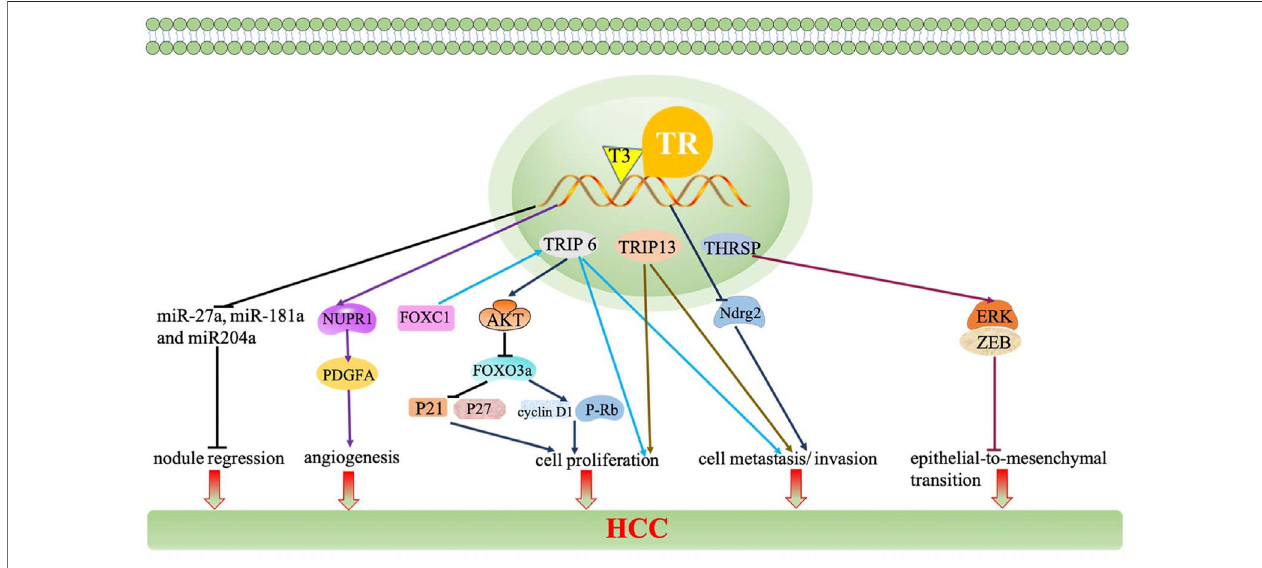
FIGURE 3 | The TH/TR axis inhibits nodule regression and decreases the expressions of miR-27a, miR-181a, and miR-204a. BC200 is inhibited by T3/TR and downregulates the expressions of CDK2, cyclin E1, and cyclin E2 and upregulates P21, thereby repressing cell growth. The downregulation of TUG1 by the TH/TR axis causes AFP mRNA, cyclin E, and H3K27me3 silence and cell growth inhibition. When TRIP is activated by FOXC1, migration, invasion, and proliferation are strongly promoted. TRIP6 induces the AKT signaling pathway, thereby preventing FOXO3a overexpression-induced cyclin D1 interference, p21 and p27 activation, and HCC cell proliferation arrest. The downregulation of PTTG1 is silenced by Sp2, which is negatively mediated by T3/TR. The activation of V-erbA leads to the depletion of Ndrg2,thusexacerbatingtumorinvasionandmetastasis.Lcn2canactivatetheMet/FAKpathwayinaTH/TRaxis-dependentmanner,thusenhancingcellmigrationand invasion. T3/TR/MEK/ERK/NUPR1/PDGFA cascade may play a vital role in hepatocarcinogenesis. T3/TR upregulates NUPR1 via binding to the NUPR1 promoter regions, therefore promoting vascular invasion. THRSP prevents silence of the ERK/ZEB1 signaling pathway and inhibits the process of epithelial-to-mesenchymal transition. DKK 4 antagonizes the Wnt signal pathway and inhibits tumor metastasis, which depends upon the activation of the T3/TR axis.